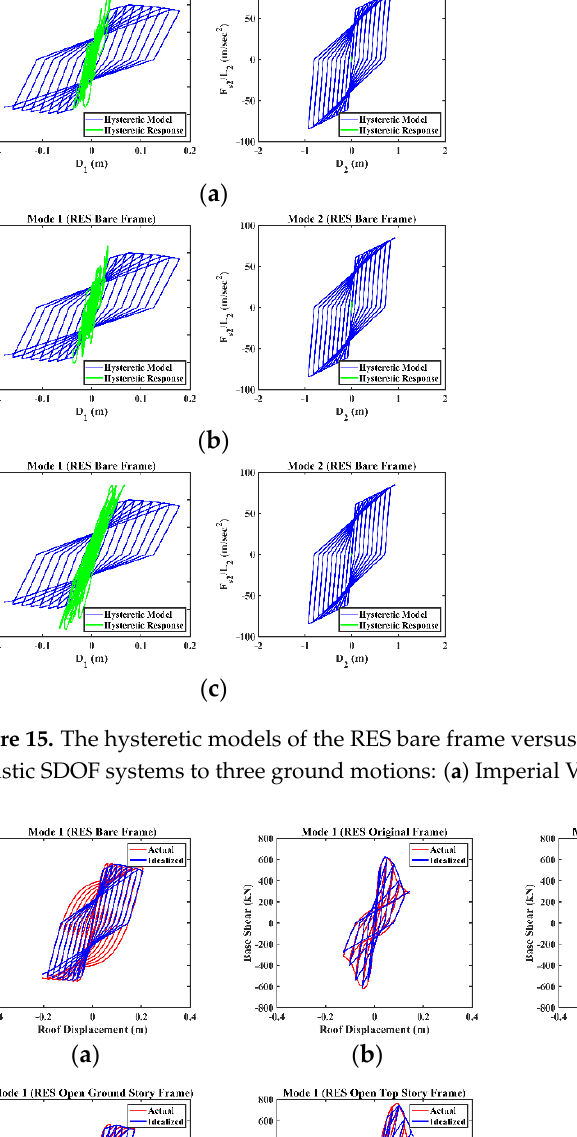
Figure 14. Mode shape and simplified concept of building RES: ( a ) first two vibration modes in the x-direction of the RES bare frame; and ( b ) 2 DOFs of RES.